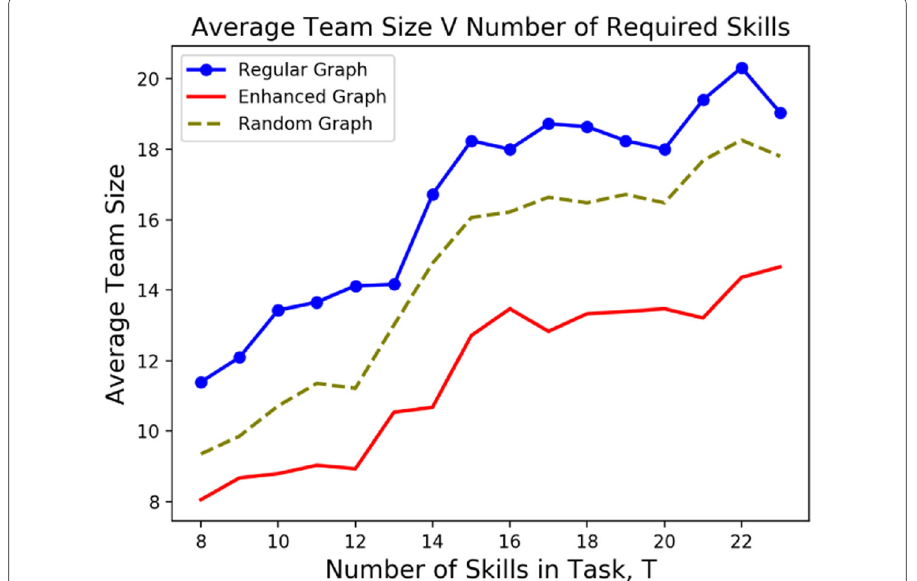
Fig. 9 Average Cardinality of IBM Team V Number of Skills in task,